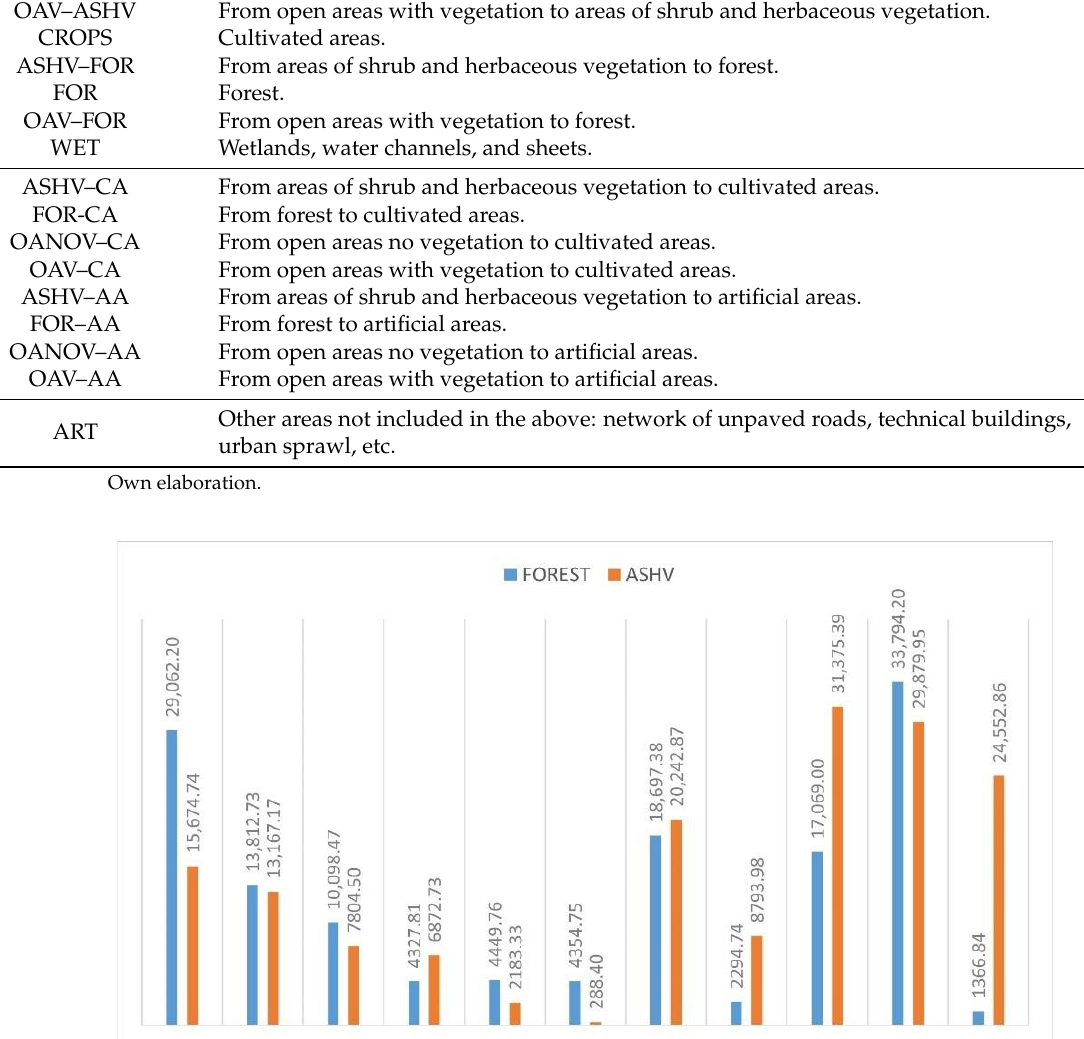
Table 11. Dynamics of change (1991 – 2021) and assessment of conservation status according to veg- etation indices (NDVI, NDWI, and EVI) of forest areas and areas of shrub and herbaceous vegetation uses. Area in hectares. N.A.